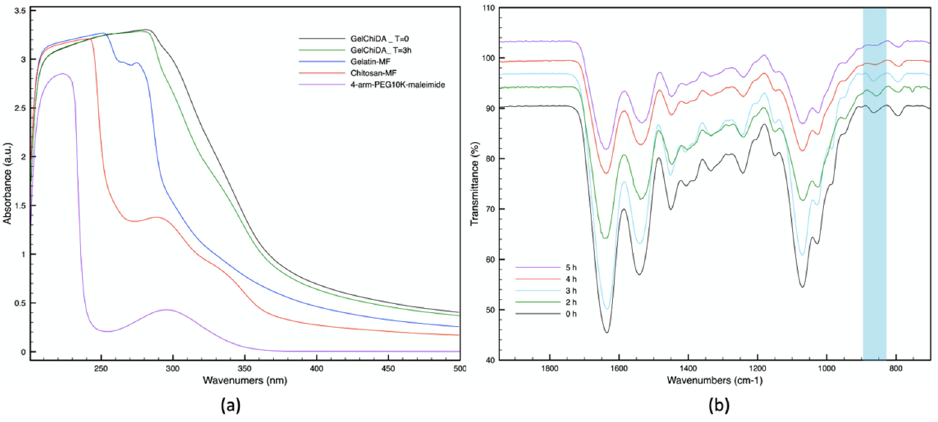
Figure 2. ( a ) UV spectra of cross-linking reaction in real time and ( b ) comparison of FT-IR spectra at different time points.